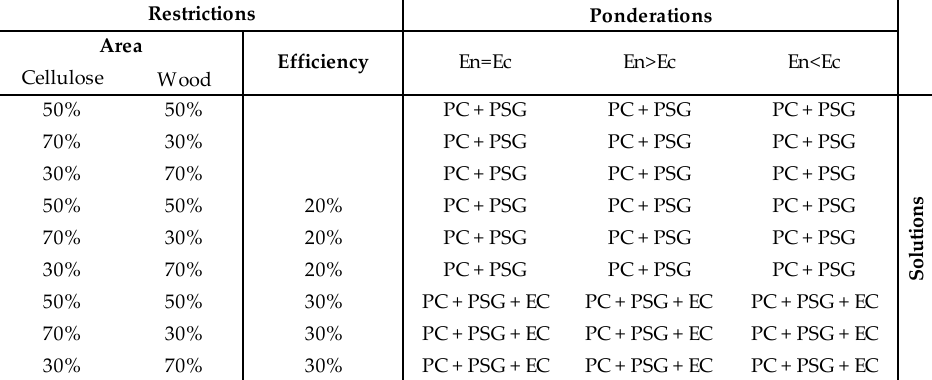
Figure7. Decisionmatrixforlanduseoptimization. En = Environmentalcriteria. Ec =